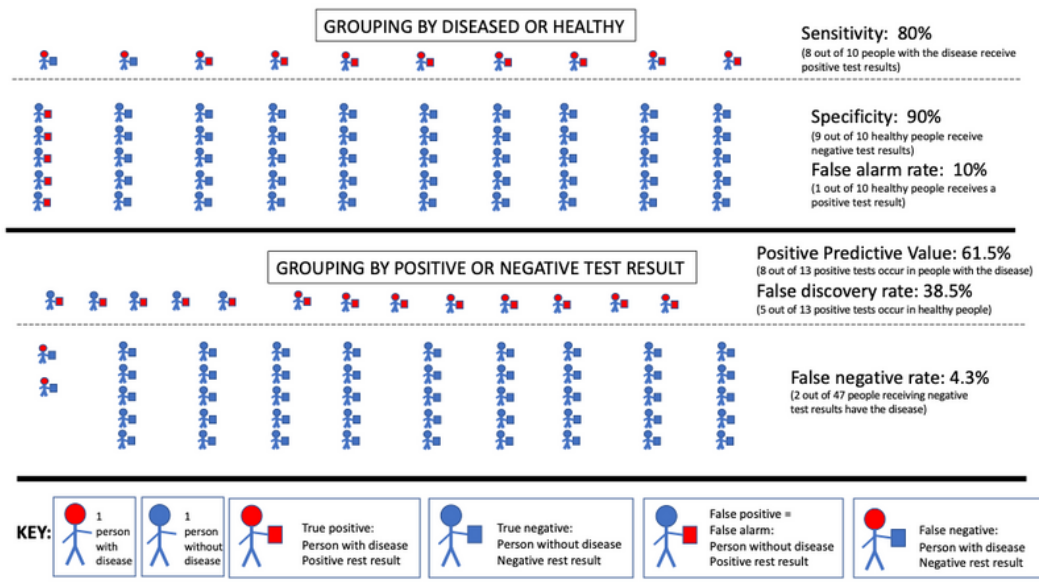
Figure 2. Definitions of test outcomes in a lower prevalence setting than Figure 1. Individuals remain grouped by health status (sensitivity and specificity) or by test result (positive predictive value, false discovery rate, and false negative rate). (See text for additional